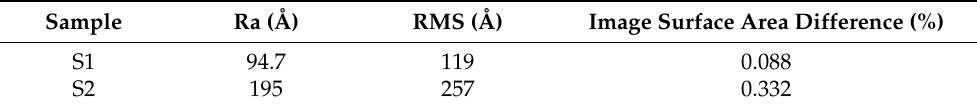
Table 2. Average roughness Ra, root-mean-square RMS, and image surface area difference of the sputtered TiO 2 layers.